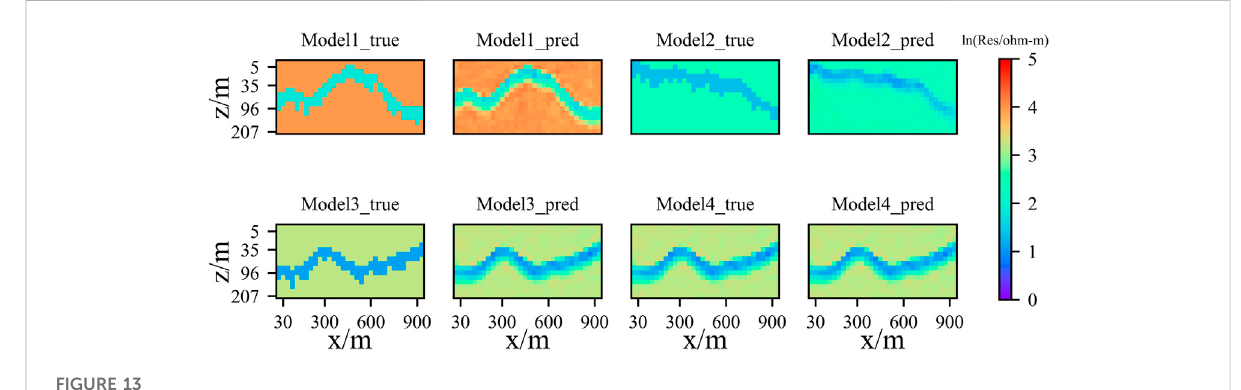
Imaging results for the synthetic data.